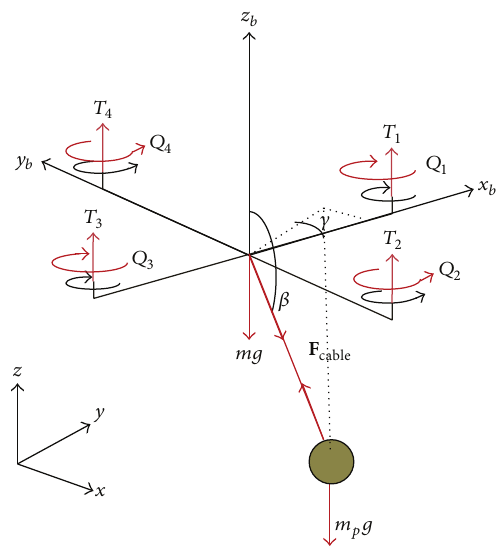
Figure 2: Free body diagram of quadrotor slung load